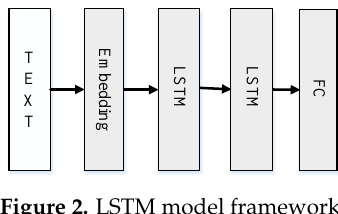
Figure 2. LSTM model framework.